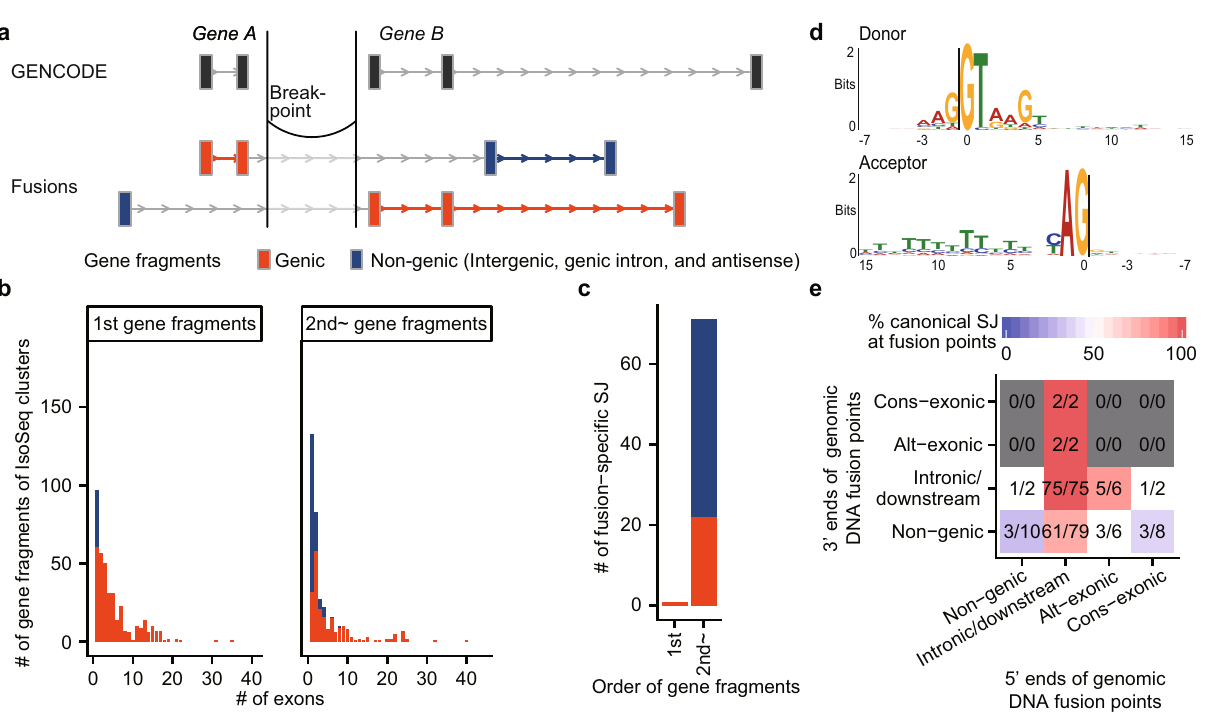
Fig. 5 Transcript structure of fusion transcripts. a Schematic of gene fragments. b Distribution of the number of exons per gene fragments according to their genomic regions and order in fusion transcripts. c Bar plots showing the number of fusion-speci fi c splicing junctions for each order of gene fragments in fusion transcripts. d Motif of fusion-speci fi c splicing junctions. Note that the fi rst two intronic bases were intentionally chosen. e A heatmap with axes representing exon – intron structures at both edges of fusion points. Colors and numbers indicate the proportions of con fi rmed canonical splice sites at fusion points. “ Non-genic ” means that the corresponding gene fragments were mapped to an intergenic, genic intron, or antisense regions. “ Intronic/ downstream ” means that a fusion point is on an intron or downstream of genes. “ Alt-exonic ” means an alternative exon, and “ cons-exonic ” means a constitutive